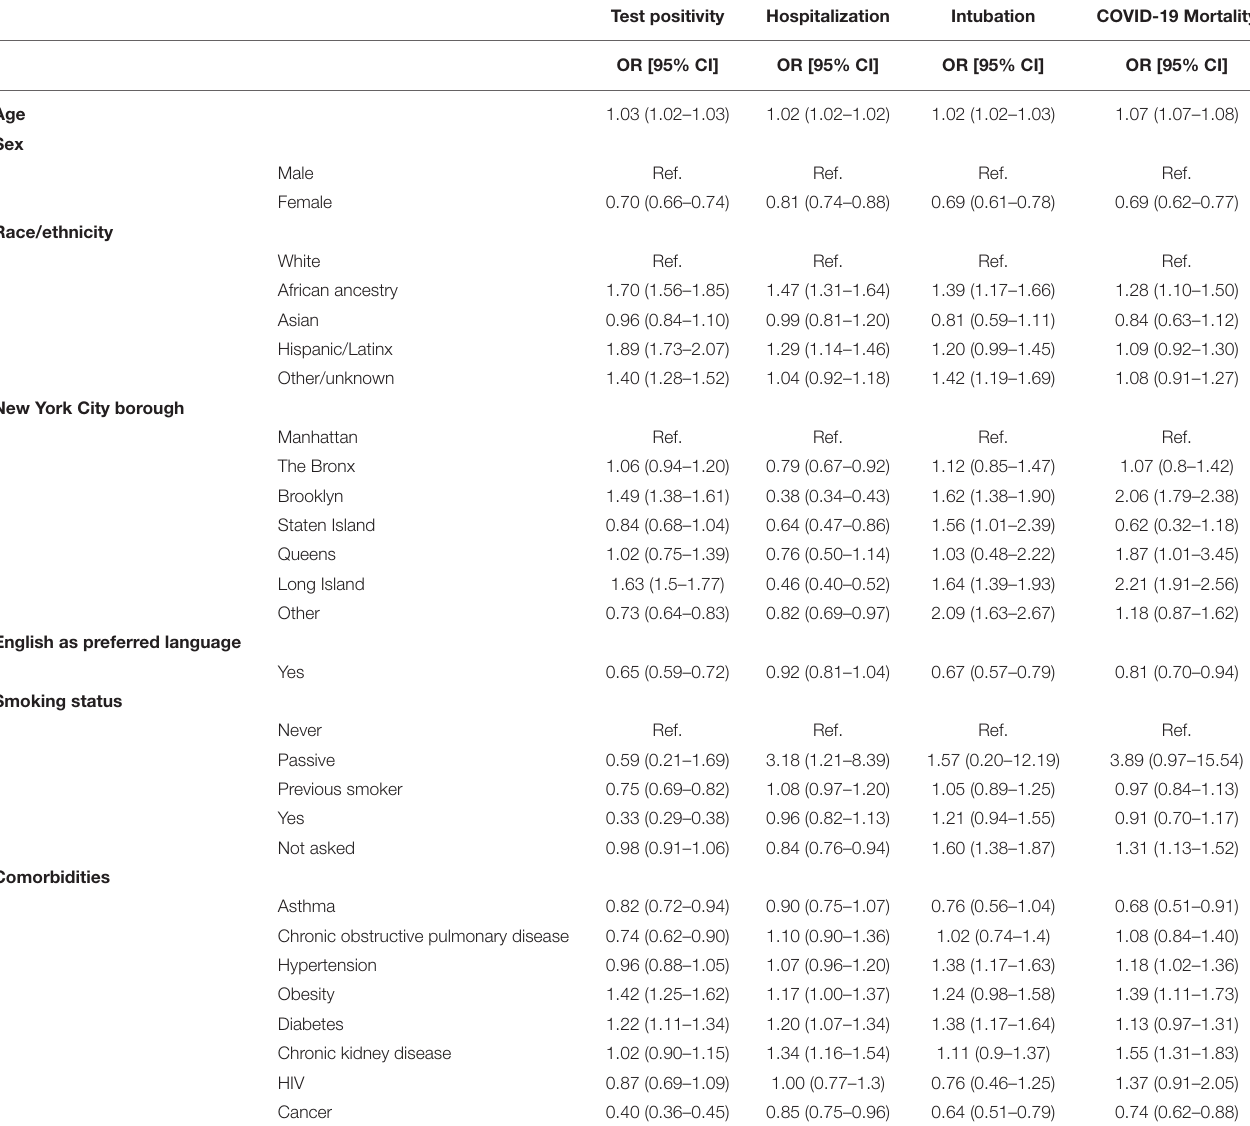
TABLE 2 | Odds ratios presented after multivariable logistic regression analyses of patients who presented to MSHS; controlling for each of the listed variables: social determinants of health (SDoH), co-morbidities and other risk